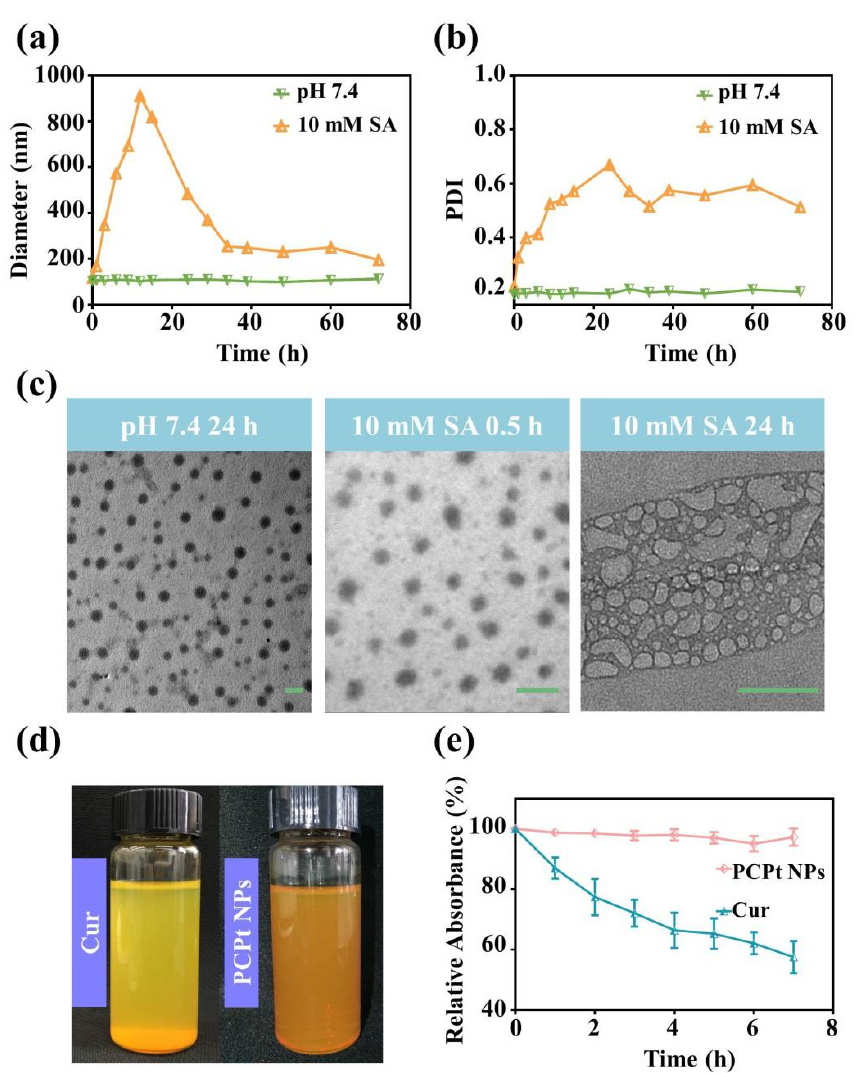
Figure 3. Stability of PCPt NPs and free Cur. ( a ) The hydrodynamic diameter of PCPt NPs meas- ured by DLS at different times (0–72 h). ( b ) PDI of PCPt NPs measured by DLS at different times (0–72 h). ( c ) TEM images observed for the morphology change of PCPt NPs after incubation at different conditions (scale bar: 100 nm). ( d ) Optical photographs taken for PCPt NPs and free Cur in PBS 7.4. ( e ) PCPt NPs and free Cur relative absorbance in PBS 7.4, at different time points, under dark condition.